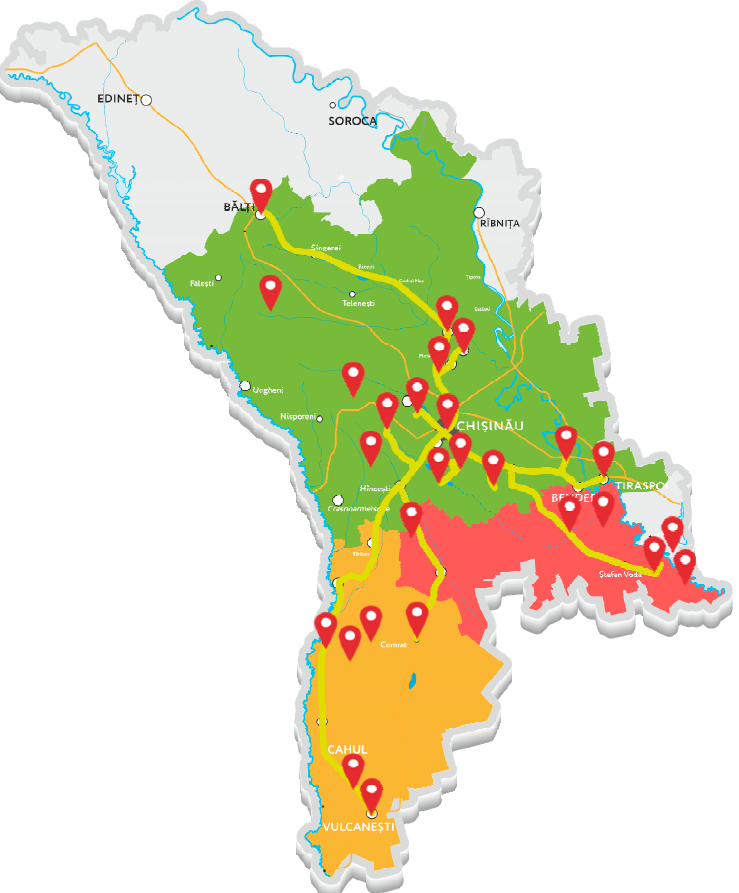
Figure 1. Map of wineries in Republic of Moldova. Sources: https://wineofmoldova.com/en/ (accessed on 16 March 2023).